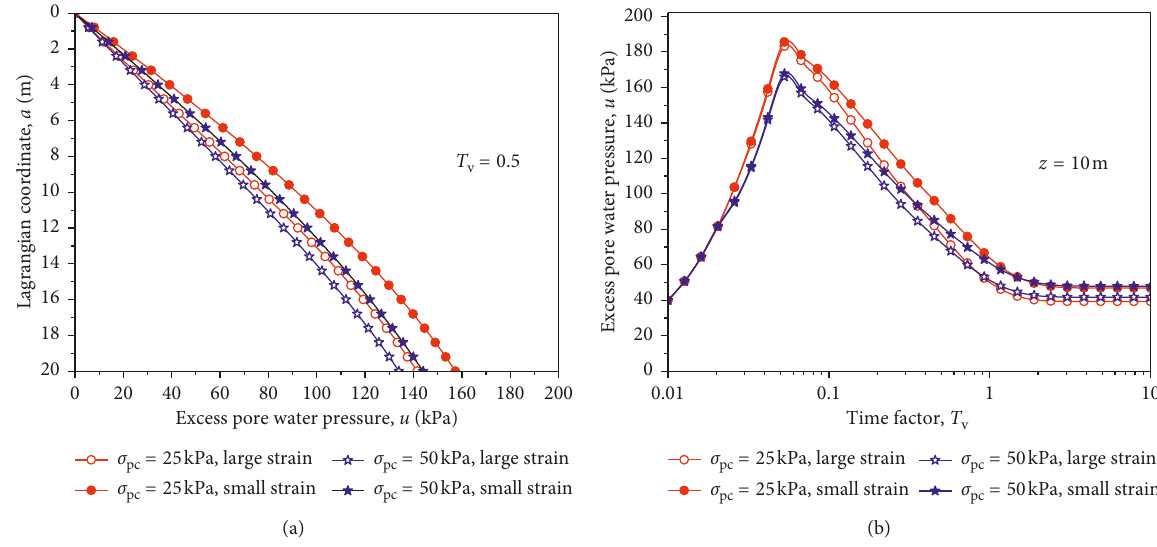
Figure 9: Influences of preconsolidation pressure on the dissipation of excess pore water pressure. (a) Curves of excess pore water pressure versus the Lagrangian coordinate a when T v � 0.5. (b) Curves of excess pore water pressure versus time factor T v at z �